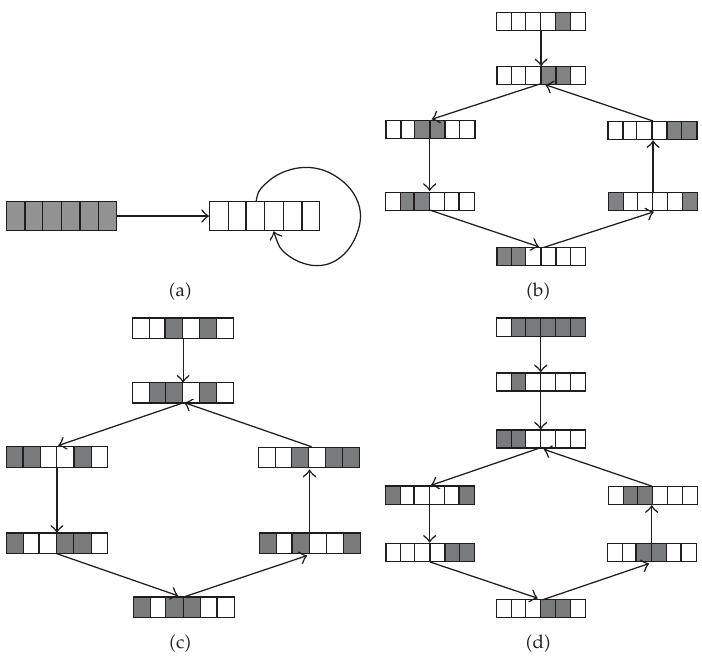
Figure 5: Some attractors of rule 14, where I (cid:7) 5, and the white pixel stands for 0 and black for 1. six, where β (cid:7) 2, σ (cid:7) 1, and τ (cid:7) 1; Figure 5 (cid:2) c (cid:3) shows that the period of attractor is six,